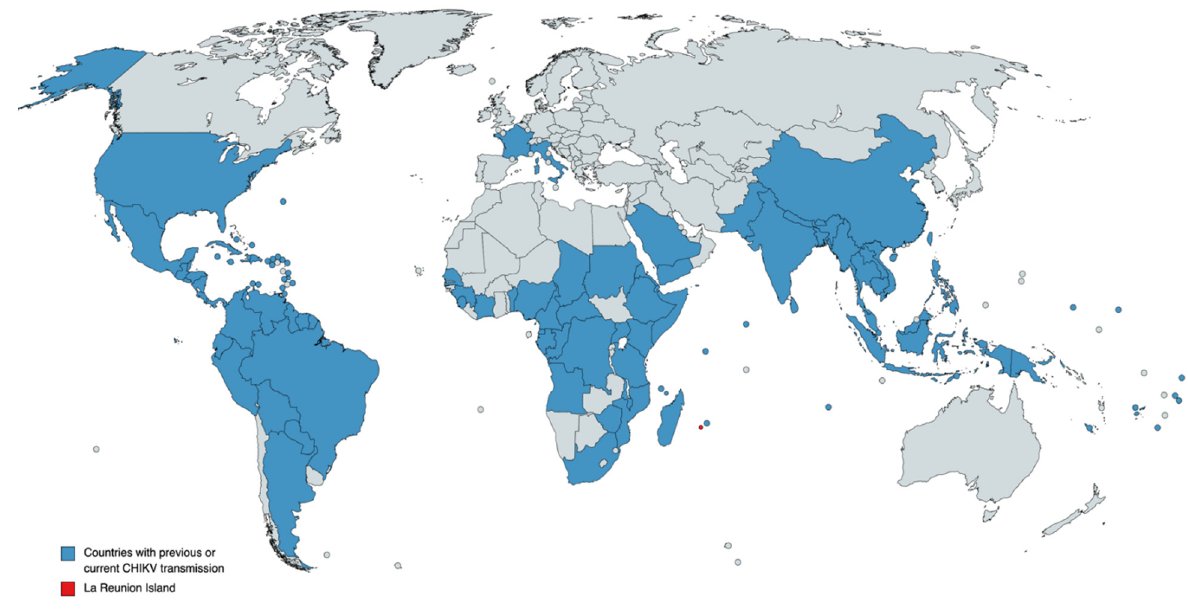
Figure 1. Countries with previous or current chikungunya transmission are blue-colored, according to the Centers for Disease Control and Prevention (CDC) (available at https://www.cdc.gov/chikungunya/geo/index.html, accessed on 28 April 2022), as reported by February 2022. La Réunion Island is red-colored, given its historical importance. Does not include imported cases. Although the United States territory of Alaska is blue-colored, no CHIKV transmission was documented in this area.